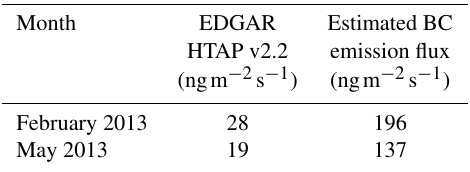
Table 4. Black carbon emission fluxes per month used in the two simulations (WRFchem_ref and WRFchem_BC) for the area of the Kathmandu